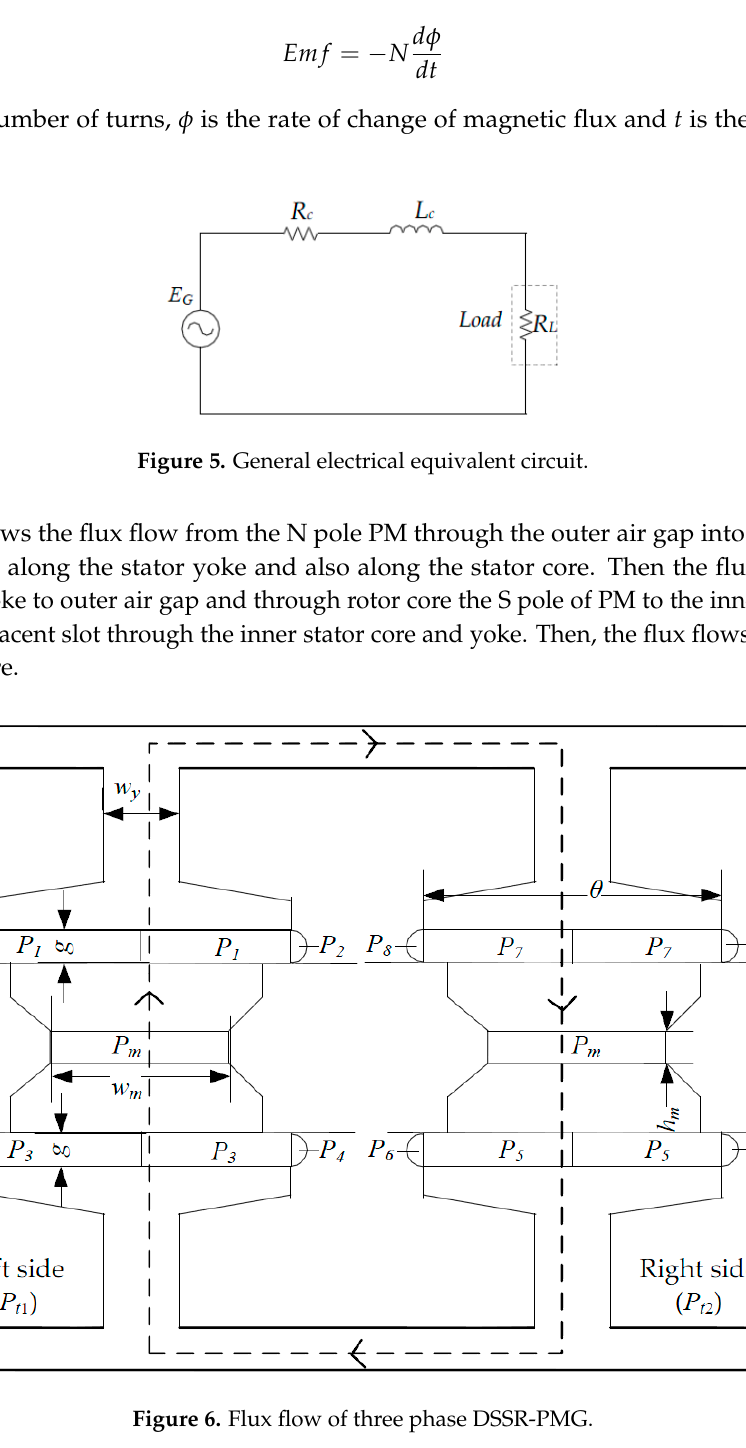
Figure 4. Flux distribution of DSSR-PMG.